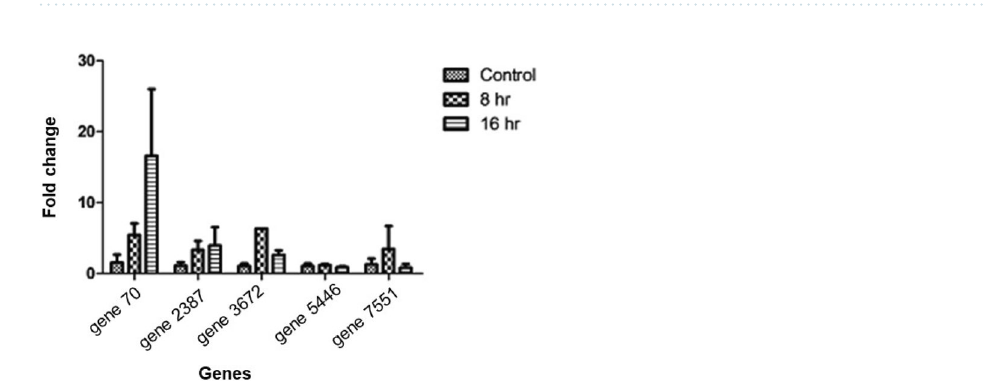
Figure 7. Expression profiling of the predicted effector molecules using ( a ) cDNA, and ( b ) DNA of S. sclerotiorum ‘ ESR-01’ isolate as a template. Lanes: predicted effector candidates, M: 100 bp DNA ladder, and Tubulin, as control.